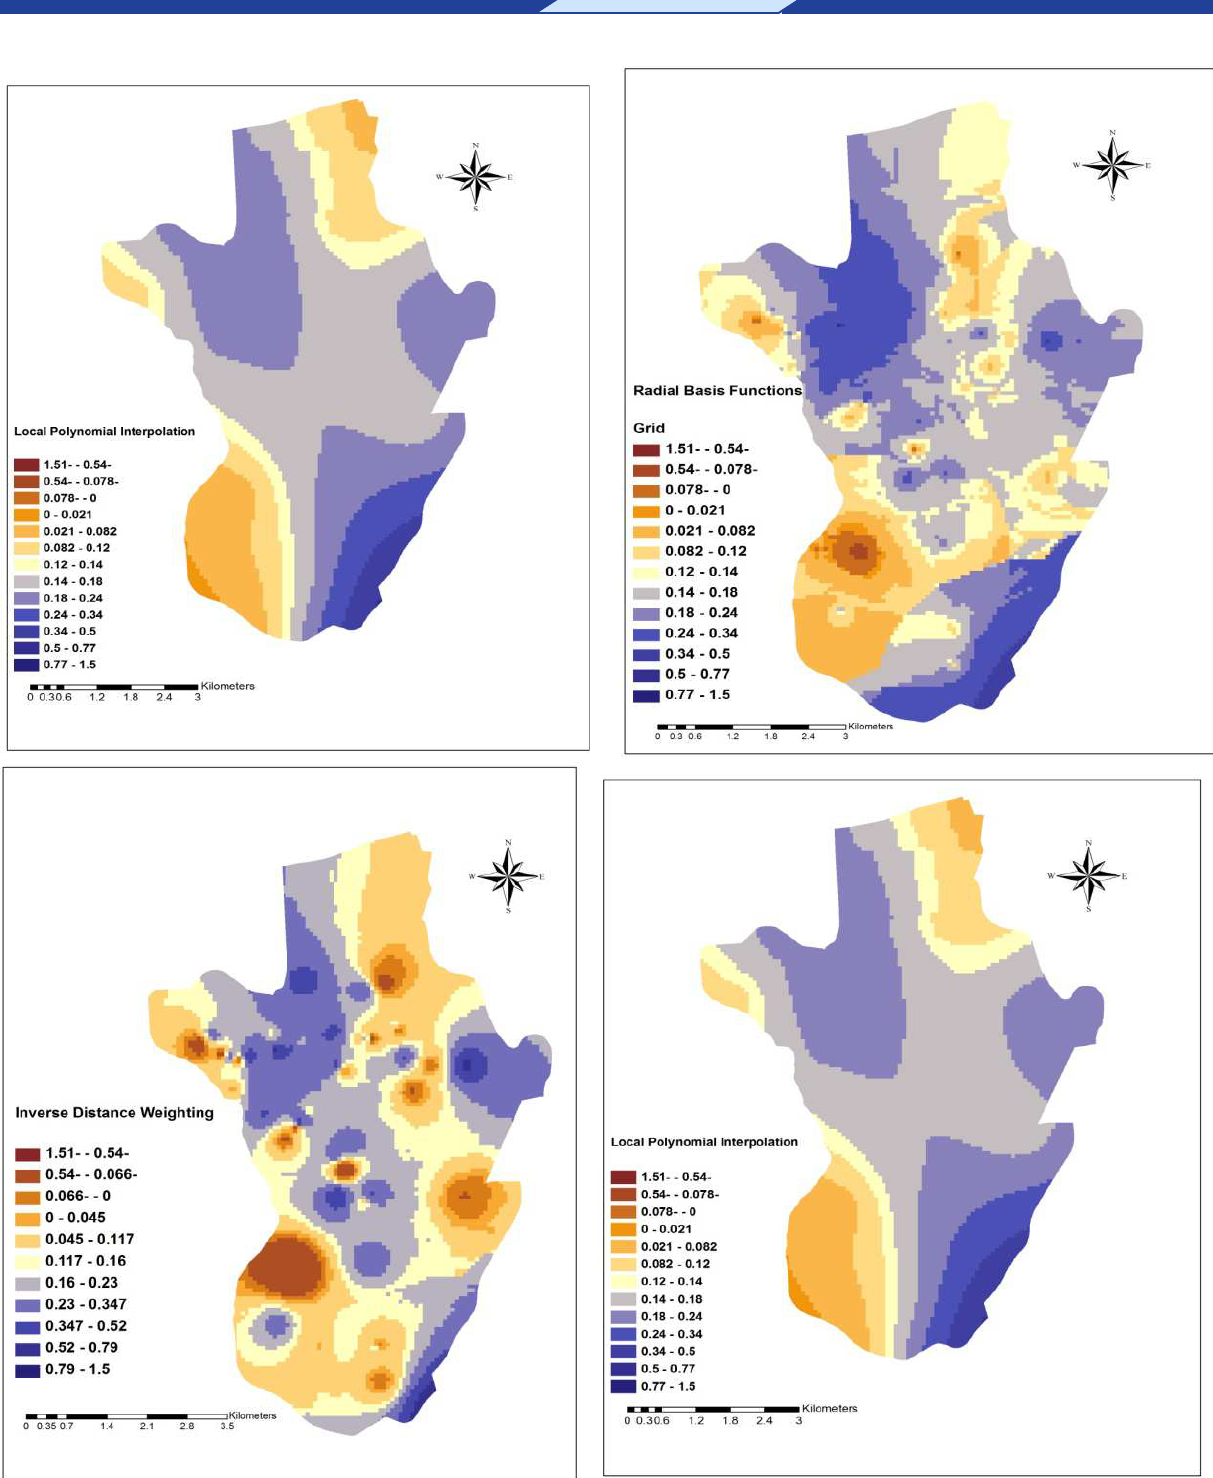
Figure 4. Spatial variations maps of Langelier saturation index by interpolation methods of OK, GPI, LPI, RBF, and